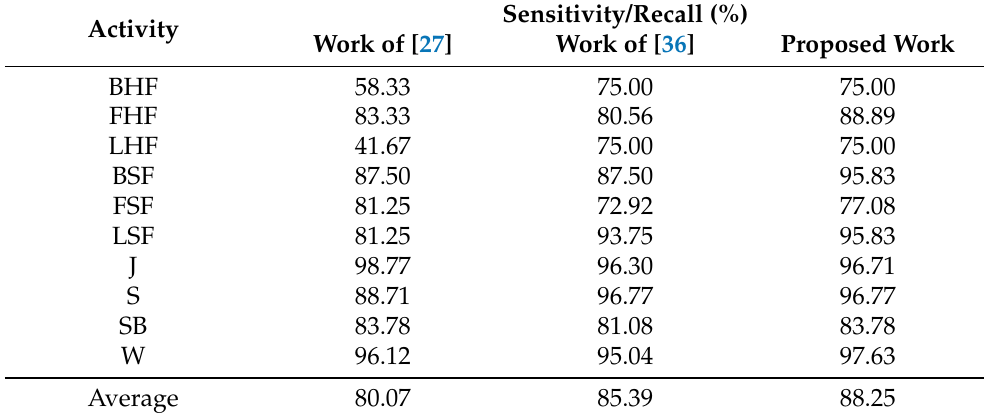
Table 4. Comparison to other